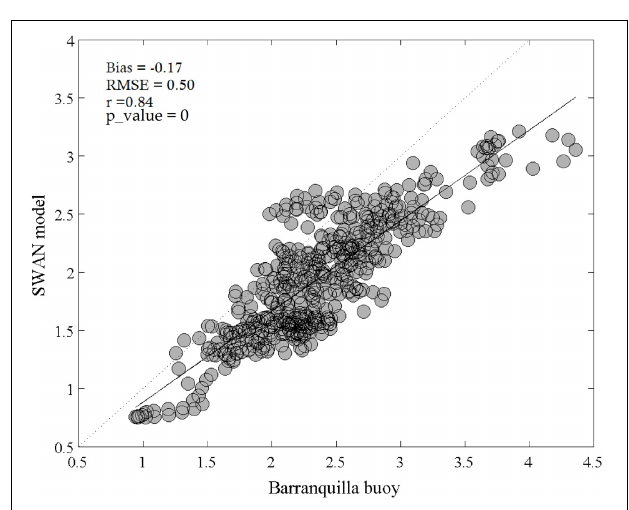
FIGURE 3 | Dispersion diagram where the WWIII data propagated with SWAN model are correlated with the wave data of the buoy 41194 available in the National Data Buoy Center of the